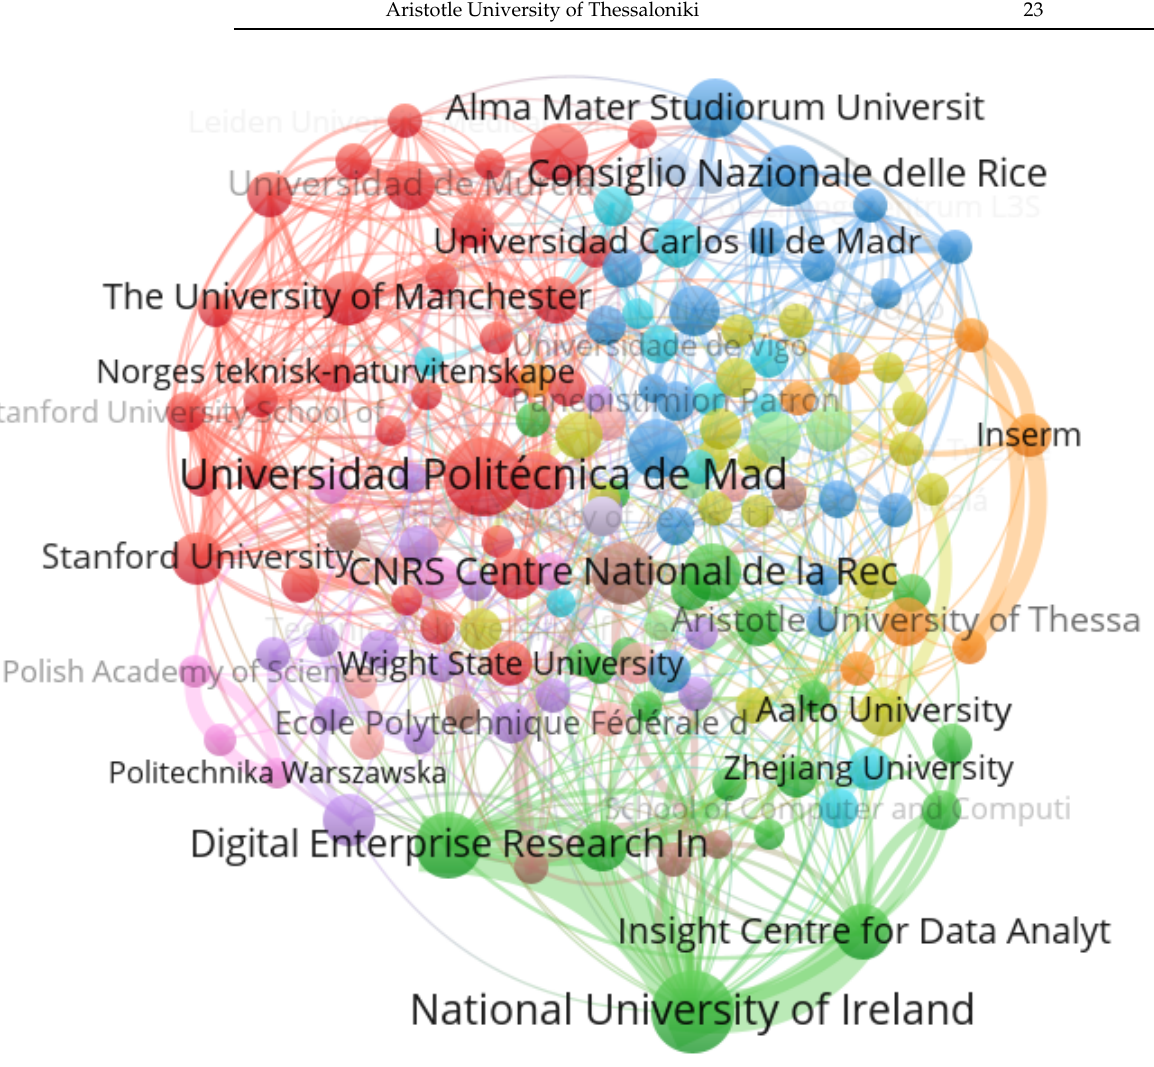
Figure 3. Network of institutional collaboration.